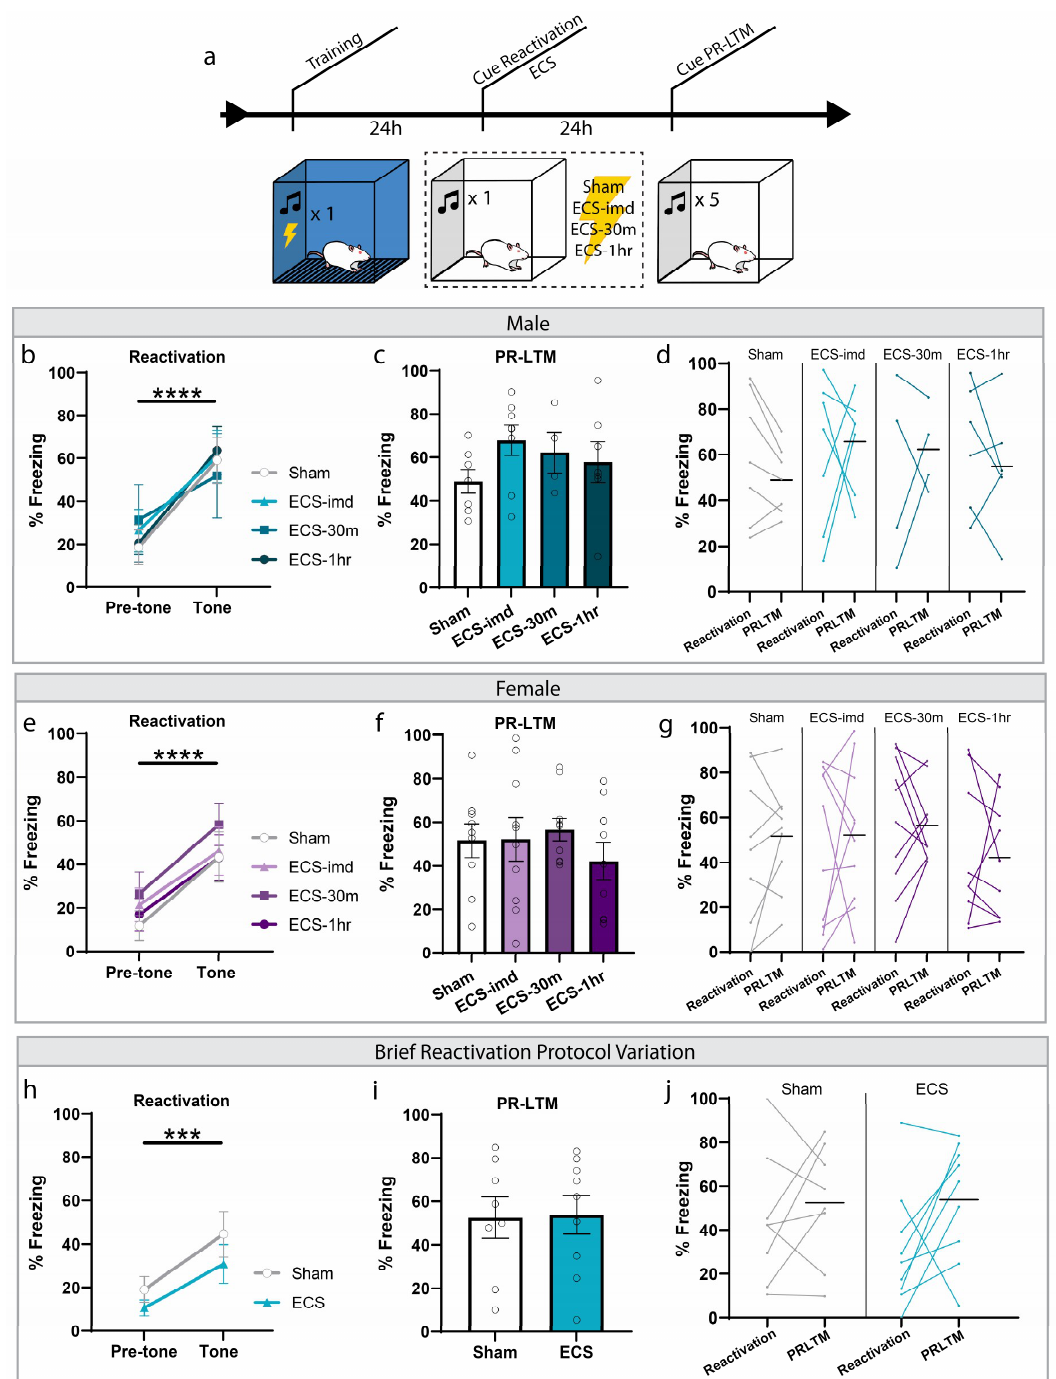
Figure 1. ECS delivery after cued reactivation does not disrupt reconsolidation of an auditory fear memory. ( a ) Schematic outline of experimental procedures used for the cue-ECS experiments. Reactivation graphs indicate that all groups formed an aversive memory associated with the tone ( b ), ( e ). Post-reactivation long-term memory LTM (PR-LTM) graphs show no difference in freezing between the groups resulting from ECS treatment ( c ), ( f ). A within-subjects comparison showed no change in any group across days ( d ), ( g ). Modifying the duration of the reactivating tone and session prior to ECS does not result in amnesia either ( h – j ). *** p < 0.001, **** p < 0.0001, error bars = standard error of the mean (SEM). Horizontal bar = PR-LTM mean. “Pre-tone” is defined as the acclimation period during reactivation, prior to the tone presentation.